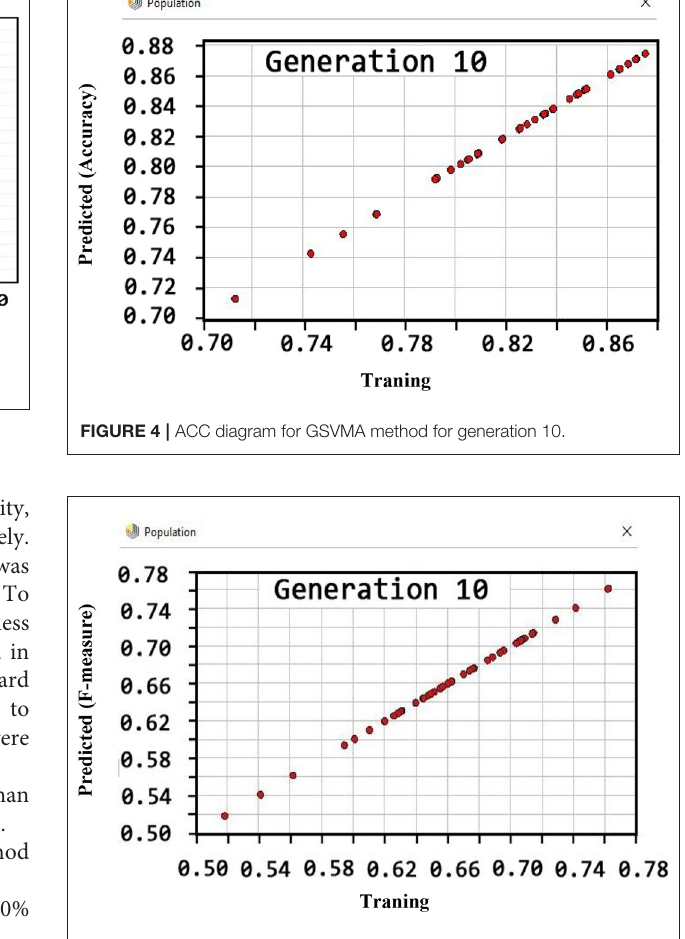
FIGURE 5 | F-measure diagram for GSVMA method for generation